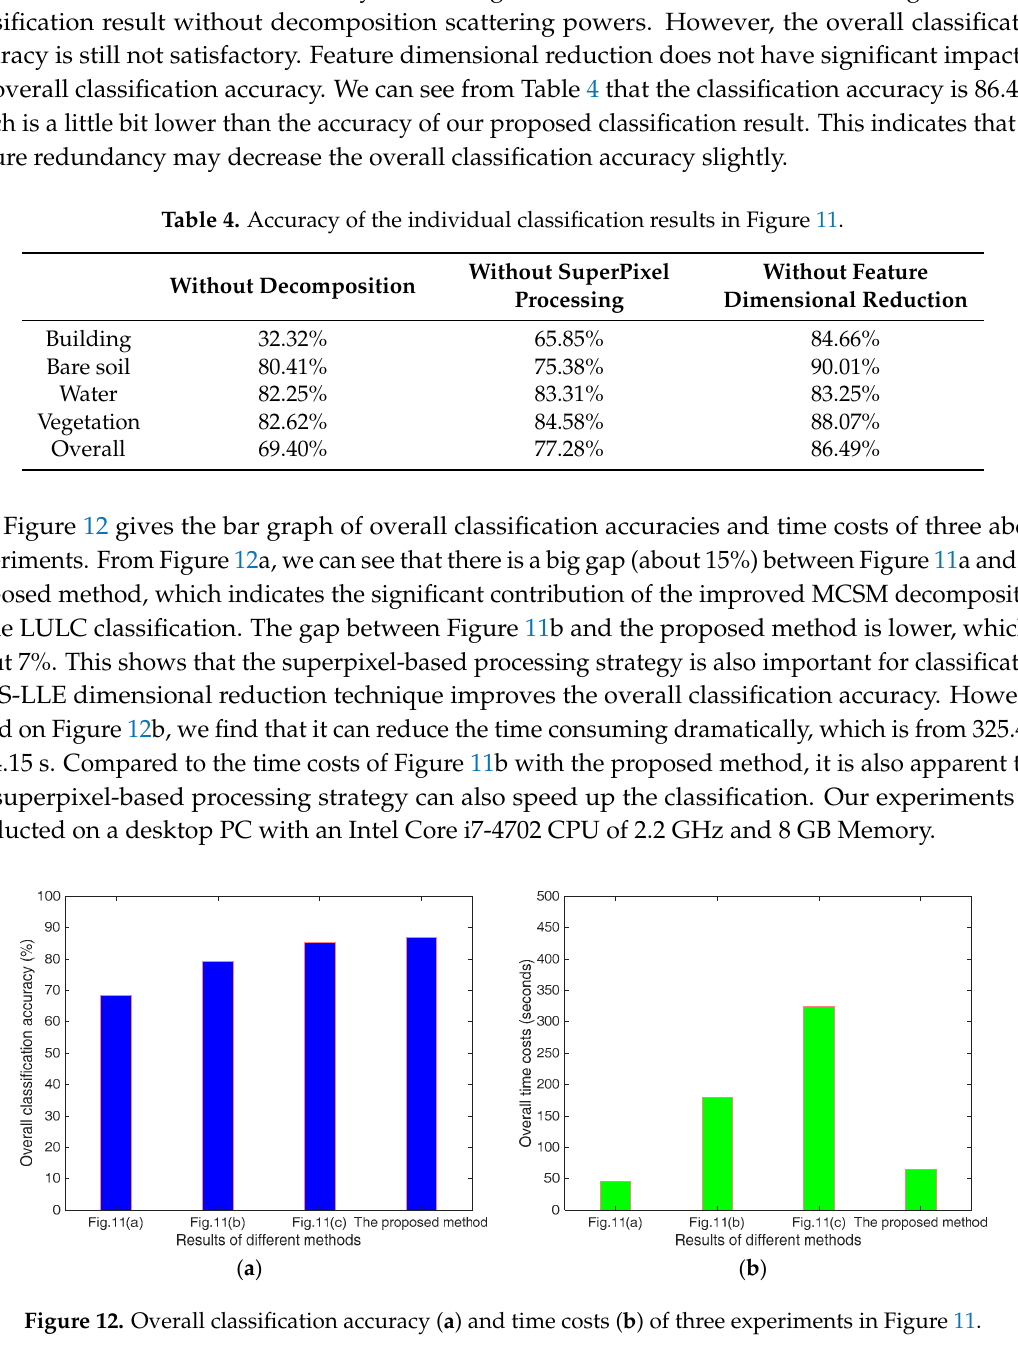
Without SuperPixel Without Feature Processing